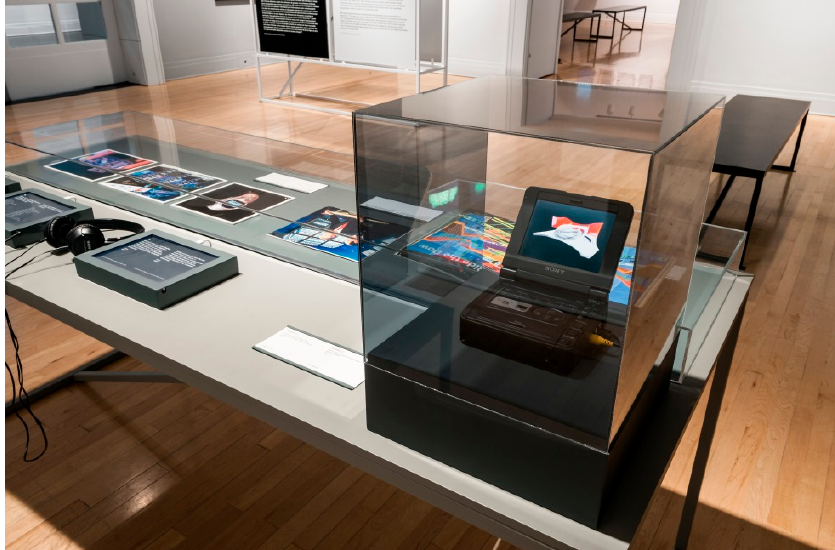
Figure 5. Archaeology of the Digital: Media and Machines, installation view of Asymptote’s design for the New York Stock Exchange and the I-Scape 1.0, Canadian Centre for Architecture, 2014. Photograph: © CCA.